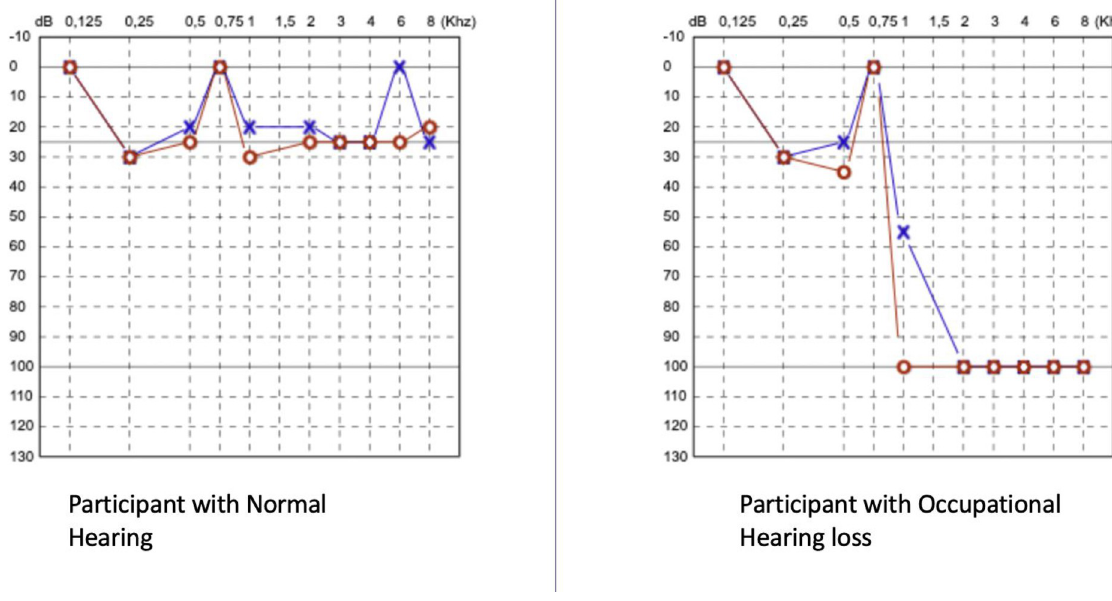
Fig 1. Audiograms generated from Wulira